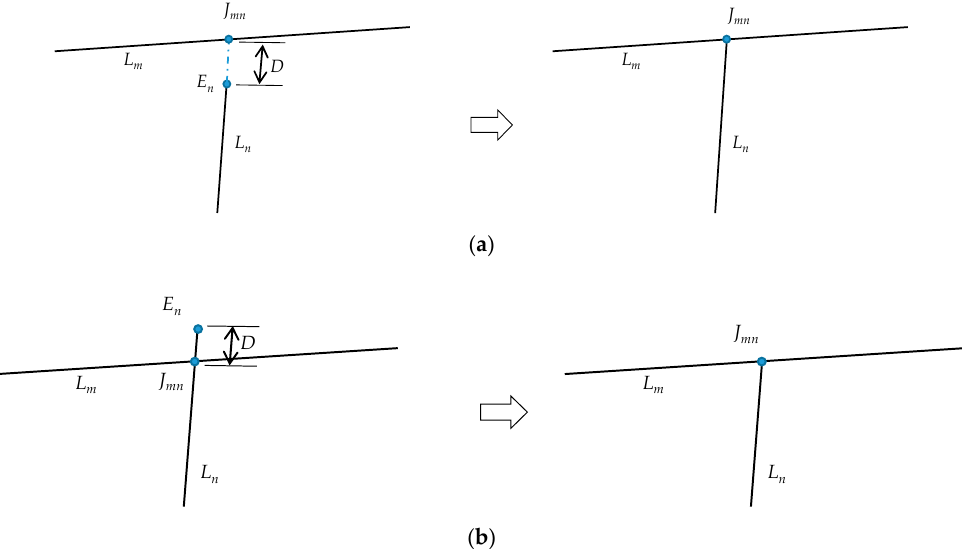
Figure 6. Sketch maps of the proposed junction optimization. ( a ) For the case of a gap; ( b ) for the case of a